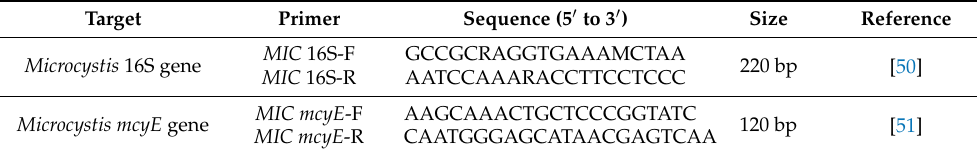
Table 1. Primers used for qPCR to amplify fragments of the Microcystis 16S rRNA gene and mcyE